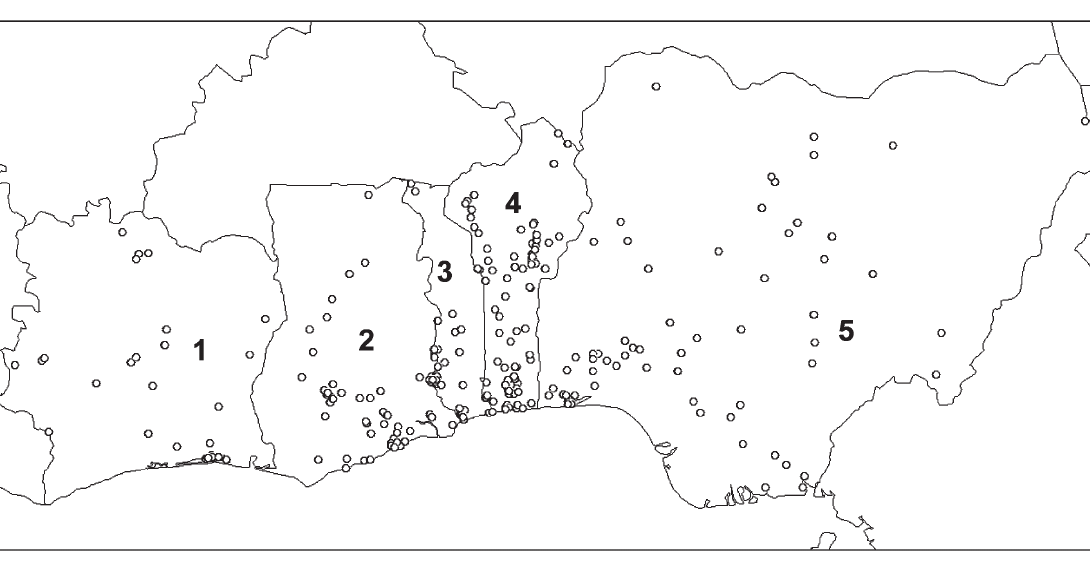
Fig. 1. Country boundaries of Ivory Coast (1), Ghana (2), Togo (3), Benin (4) and Nigeria (5) with sites of collecting events for Tephritidae (open